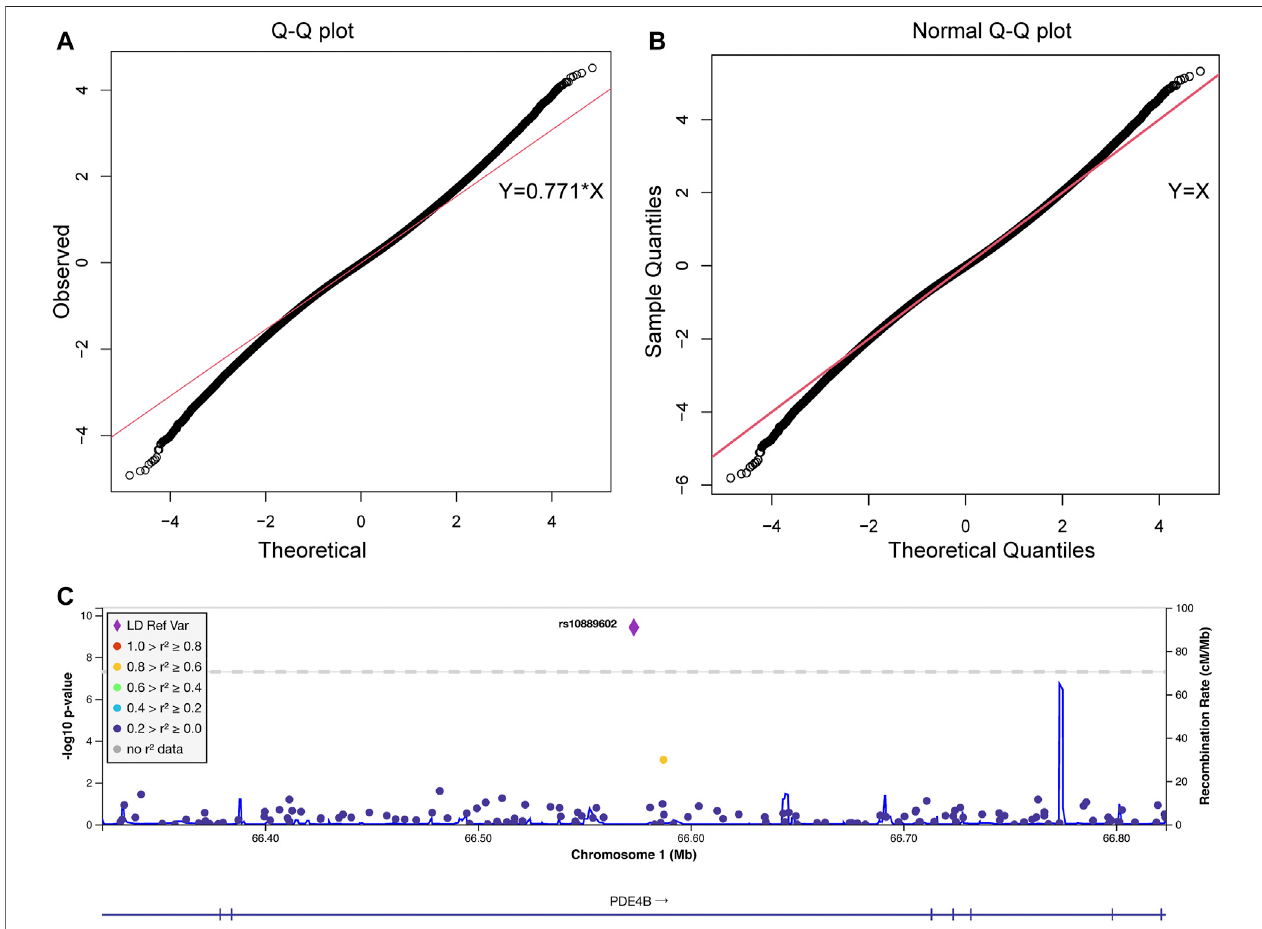
FIGURE 1 | The quantile-quantile plot of the pooling-based genome-wide association analysis and the association results of the PDE4B region. The quantile- quantile (QQ) plots were drawn before (A) and after (B) standard normal distribution transformation. The X -axis indicates the observed quantiles of the Z score in our analysis, and the Y -axis indicates the quantiles of the Z score under a standard normal distribution. The red line indicates the standard line passes through the fi rst and thirdquartiles.Theformulaofthestandardlinein (A) wasY (cid:1) 0.771*X,whichindicatesourresultsconformwithanormaldistributionwithastandarddeviationequal to 0.771. (C) Association signals in the PDE4B region. Theplot wasdrawn byLocusZoom. The X -axis indicates the physical position ofeach genotyped SNP according to the human genome reference (hg19). The left Y -axis indicates the log transformed p -value, which was used for labeling the dots and rhombus, and the right Y -axis indicates the recombination rate, which was used for labeling the blue lines in the main fi gure. The rhombus indicates rs10889602T/G. The color of the dots represents the linkage disequilibrium with rs10889602T/G measured by R 2 (legend at